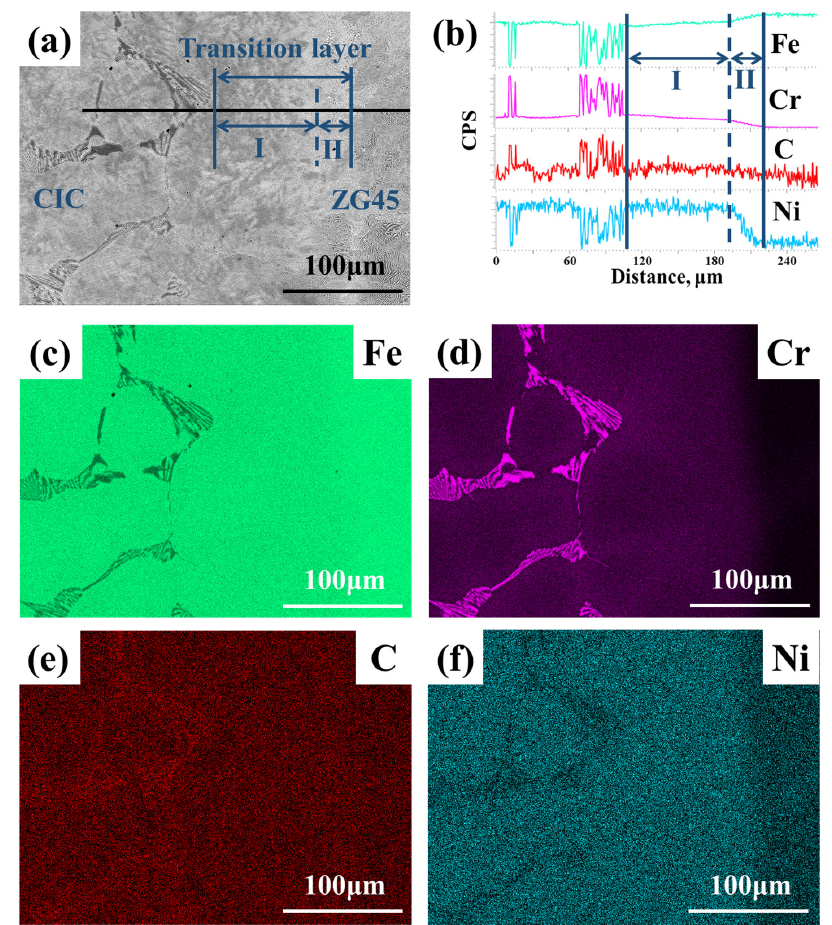
Figure 7. Interface of the sample CIC-3: ( a ) SEM image; ( b ) EDS line scanning result of the black line in ( a ); EDS mapping scanning results for ( c ) Fe, ( d ) Cr, ( e ) C and ( f ) Ni.